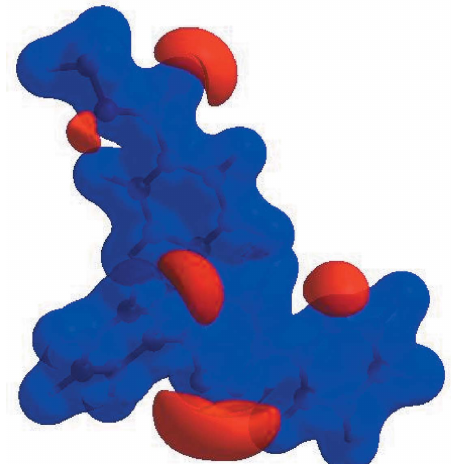
Figure 4 View of the three-dimensional Hirshfeld surface of the title compound plotted over the electrostatic potential energy in the range (cid:3) 0.0500 to 0.0500 a.u. using the STO-3G basis set at the Hartree–Fock level of theory. Hydrogen-bond donors and acceptors are shown as blue and red regions around the atoms corresponding to positive and negative potentials, respectively.